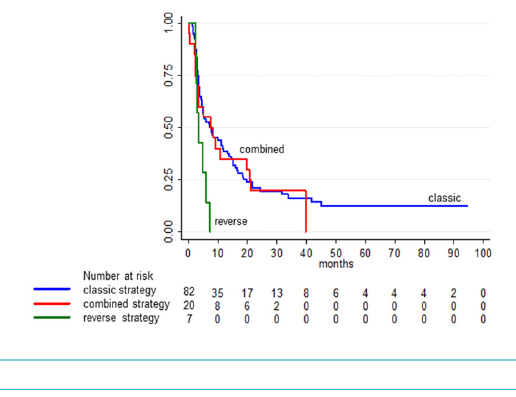
Figure 3: Impact of perioperative chemotherapy on overall survival. Median overall survival was 31.5 months (IQR 2.1 months – not reached) without chemotherapy vs 40.2 months (IQR 11.8–92.7 months) with any chemotherapy.